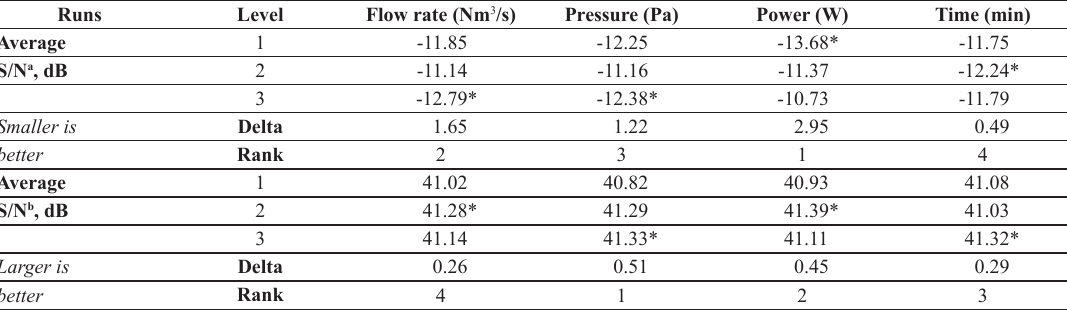
Table 4. Response table for mean of S/N ratio to optimize thermal resistance and air permeability of the fabric. Runs